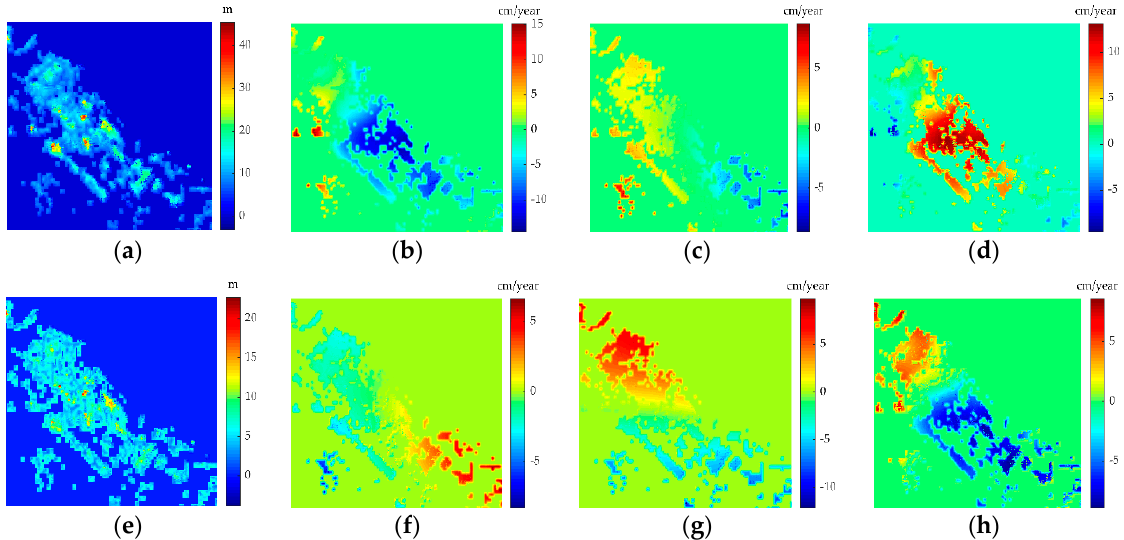
Figure 13. Estimations of elevation and deformation maps. ( a – d ) are the estimated elevation of the dominant scatterer and its estimated deformation velocities along the slant range, azimuth, and elevation directions, respectively. ( e – h ) correspond to the secondary scatterer.